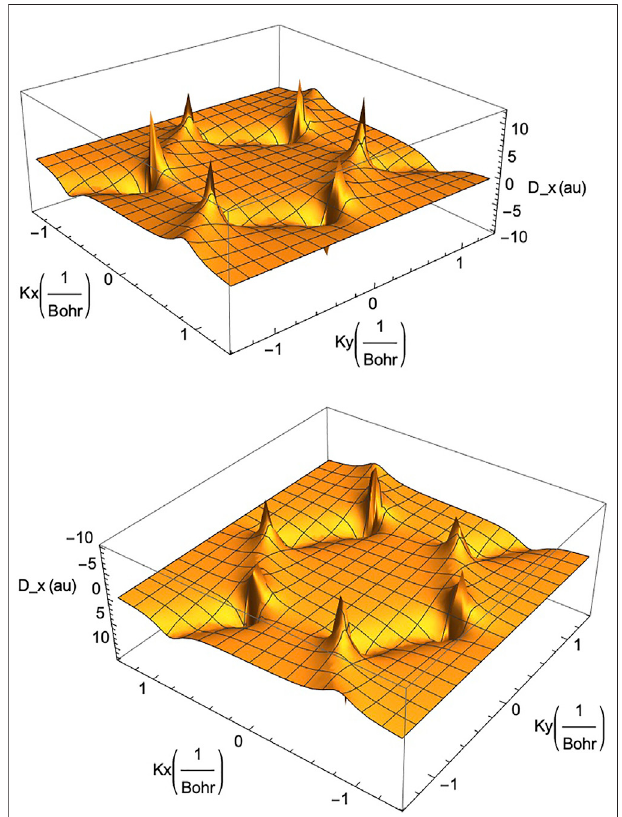
FIGURE 6 | The transition dipole moment operator for monolayer graphene along the x -axis, D x ( k x , k y ), in the reciprocal space ( k x , k y )-plane. Note the highpositivevalues(upperpart)and high negative values (lower part) at the corners of the Brillouin zone. A similar behaviour holds for the componentofthedipoleoperatoralongthe y -axis, D y ( k x , k y )(notshownhere).